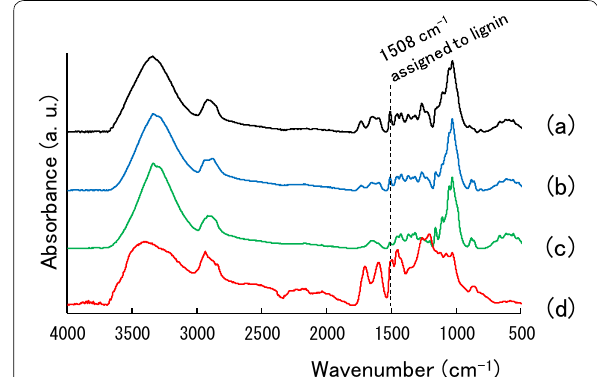
Fig. 2 IR spectra obtained from the radial face of wood block before and after alcoholysis. a–d correspond to Samples 0, 19, 15 and 8